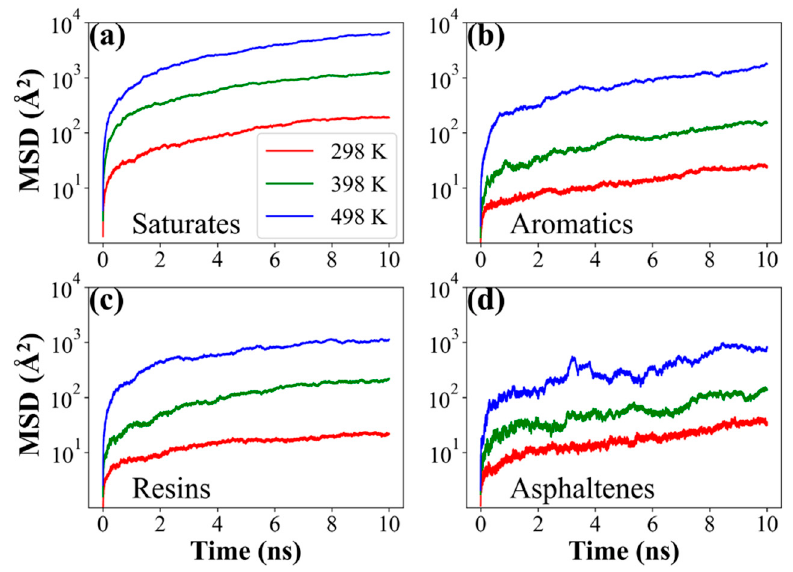
Figure 11. The MSD curves of saturates, aromatic, resin, and asphaltene molecules in heavy oil droplet at 298 K, 398 K, and 498 K, respectively.